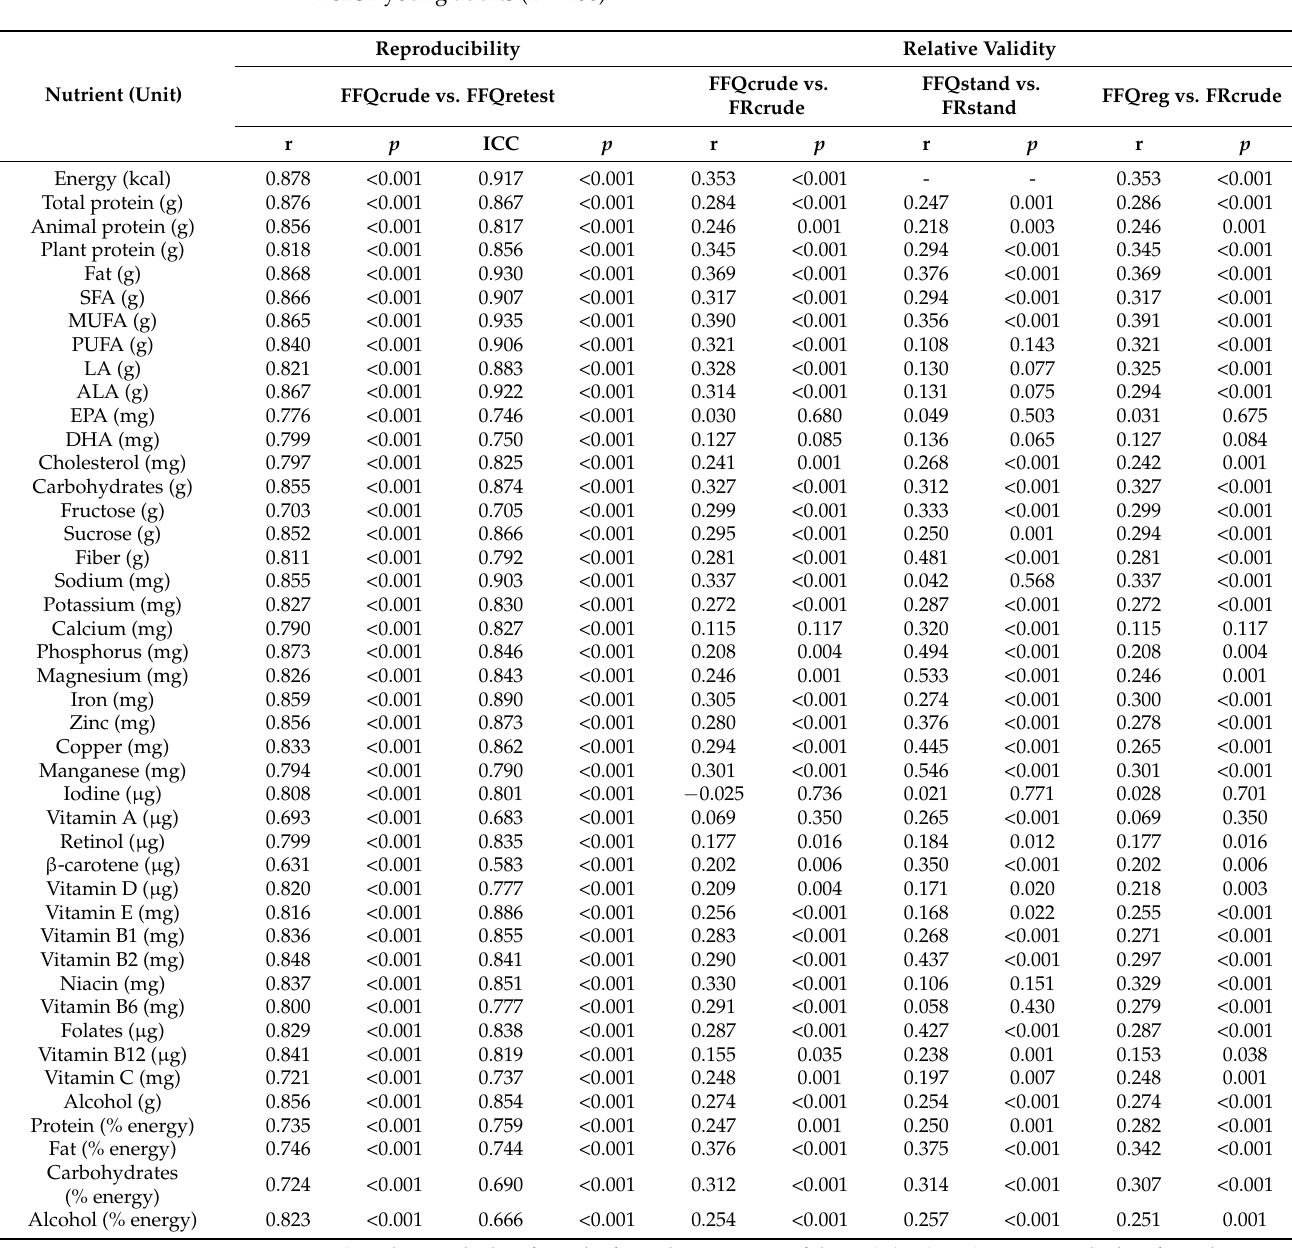
Table 3. Spearman’s correlation and intraclass correlation coefficient (FFQ reproducibility only) for energy and nutrient intake obtained with the 72-item SQ-FFQ and estimated food record (FR) among Polish young adults ( n =